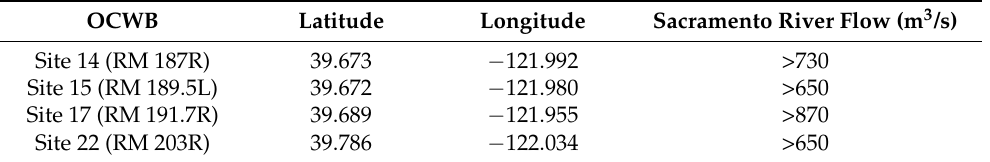
Table 3. Off-channel water bodies used for mNDWI threshold calibration. Reference names and coordinates extracted from [17]. Location along the Sacramento River is shown in Figure 1.